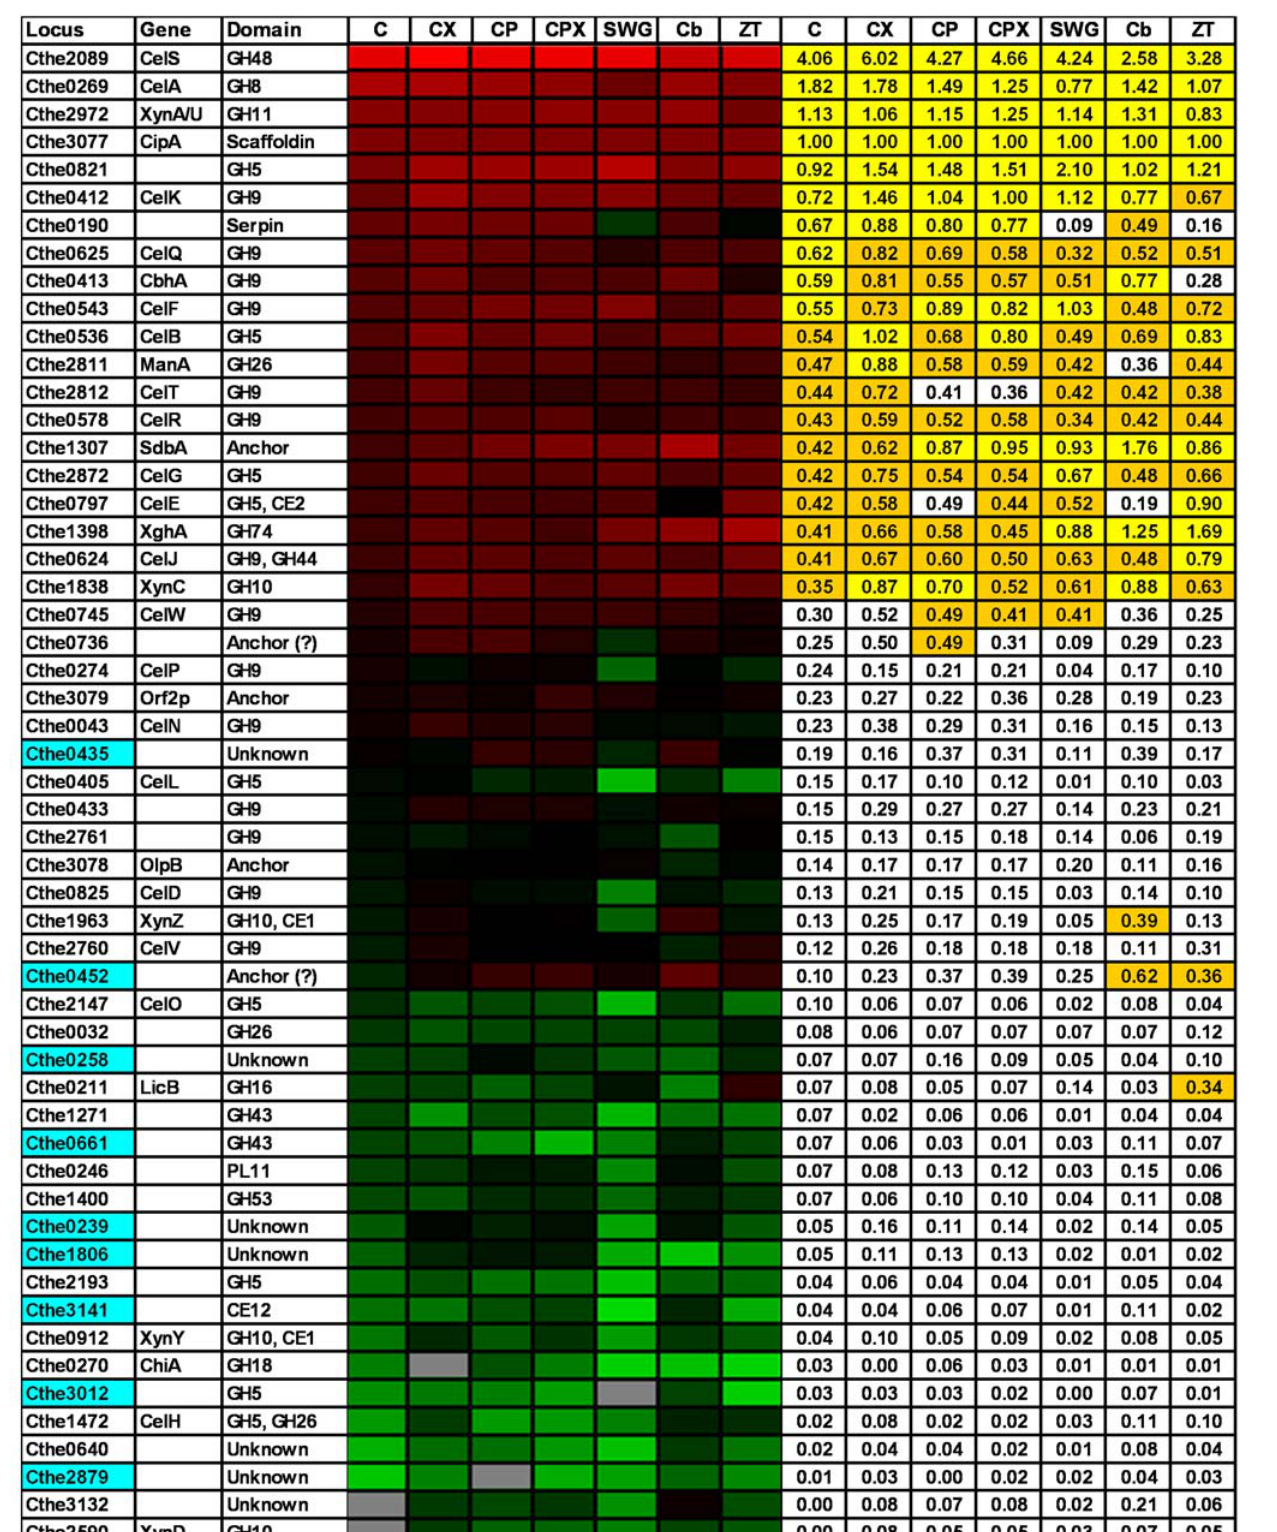
Figure 4. Weighted-Normalized Spectral Abundance Factor (Weighted-NSAF) of cellulosomal components in mass spectrometry analysis. Weighted-NSAF data for 14 N isotopologs across seven different samples is arranged in descending order of values for cellulose sample. For each cellulosomal sample, the average NSAF value of the various components was divided by the value for the scaffoldin protein CipA to obtain weighted-NSAF values. Heat plot representation shows weighted-NSAF distribution (Red, highest; Green, lowest) of 54 cellulosomal subunits. The